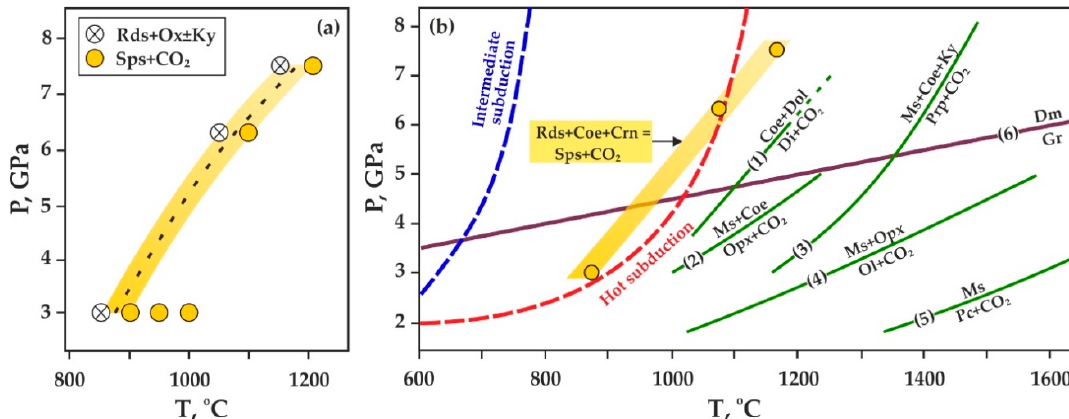
Figure 5. P - T diagrams with ( a ) experimentally determined decarbonation reaction, associated with the formation of spessartine and CO 2 -fluid; and ( b ) previously constrained decarbonation curves after [39] (1), [40,41] (2), [23] (3), [42,43] (4), [44] (5) and graphite-diamond transition line (6) [45]. Ms—